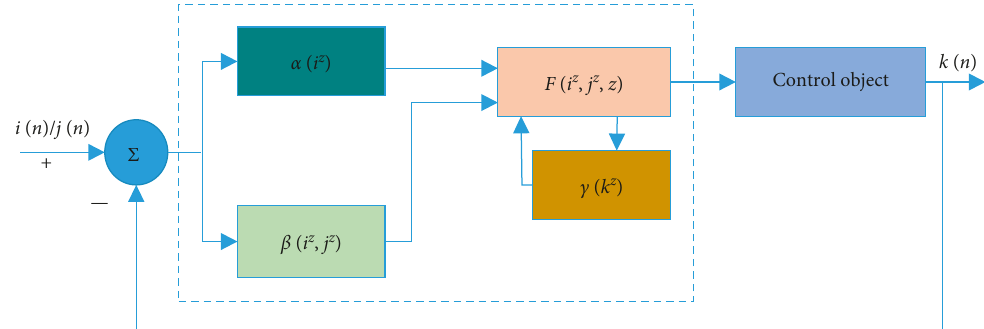
Figure 1: Structure diagram of variable universe fuzzy control